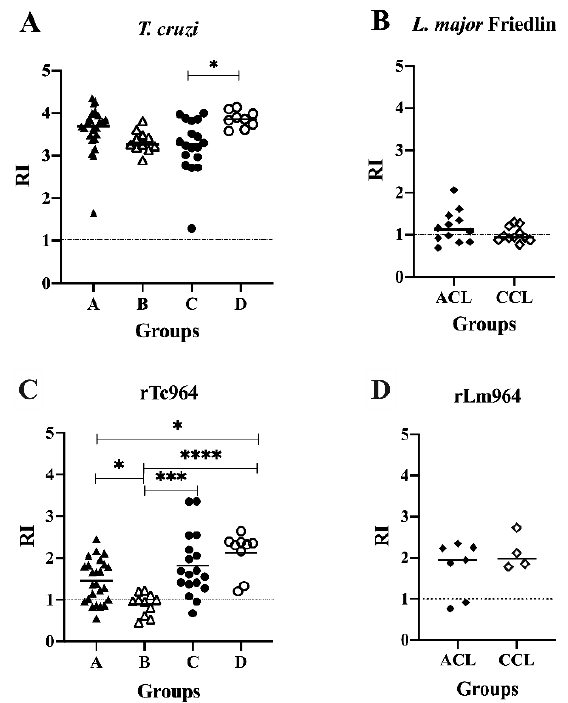
Figure 4. Antigenicity of the Tc964 and Lm964 recombinant proteins. ( A )ELISA test, using a protein lysate of T. cruzi Y (DTU II) epimastigotes and sera from patients at different stages of CCD severity: Asymptomatic (A, n = 25; B, n = 11), symptomatic (C, n = 18; D, n = 9). ( B ) ELISA test, using a protein lysate of L. major promastigotes and sera from ACL ( n = 12) and CCL ( n = 11) patients. ( C ) ELISA test, using the rTc964 protein as antigen and sera from CCD patients at different stages of disease. ( D ) ELISA test, using rLm964 protein and sera from ACL ( n = 7) and CCL ( n = 4) patients. Mean values are indicated by horizontal lines. The RI corresponds to the average derived from two (2) replicas. The p values were calculated using the Mann-Whitney U test (ns p > 0.05) for ( B ) and ( D ) and one-way ANOVA nonparametric Kruskal–Wallis test with Dunn’s posttest (* p < 0.05, *** p < 0.001, **** p < 0.0001) for ( A )and ( C